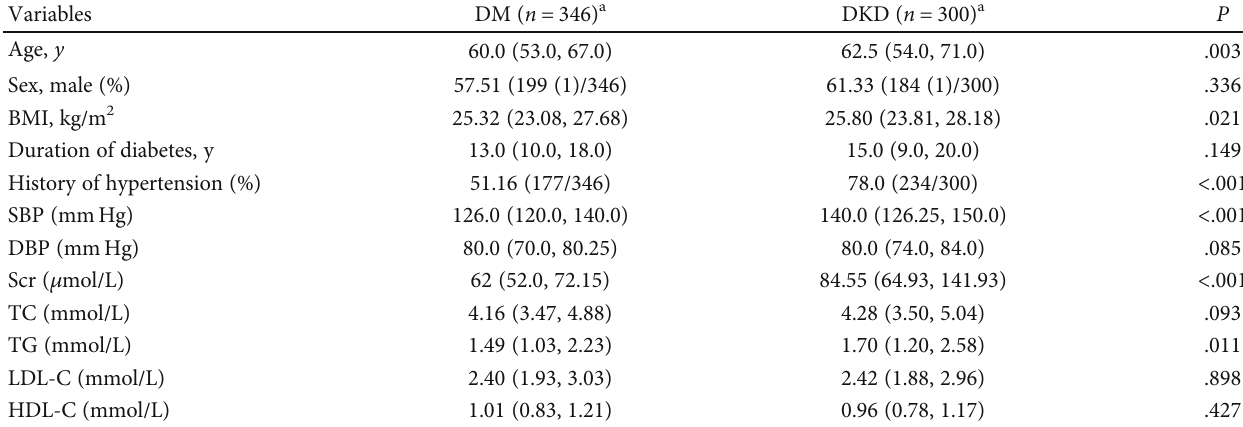
Table 1: Demographics and clinical characteristics of DM patients with and without kidney